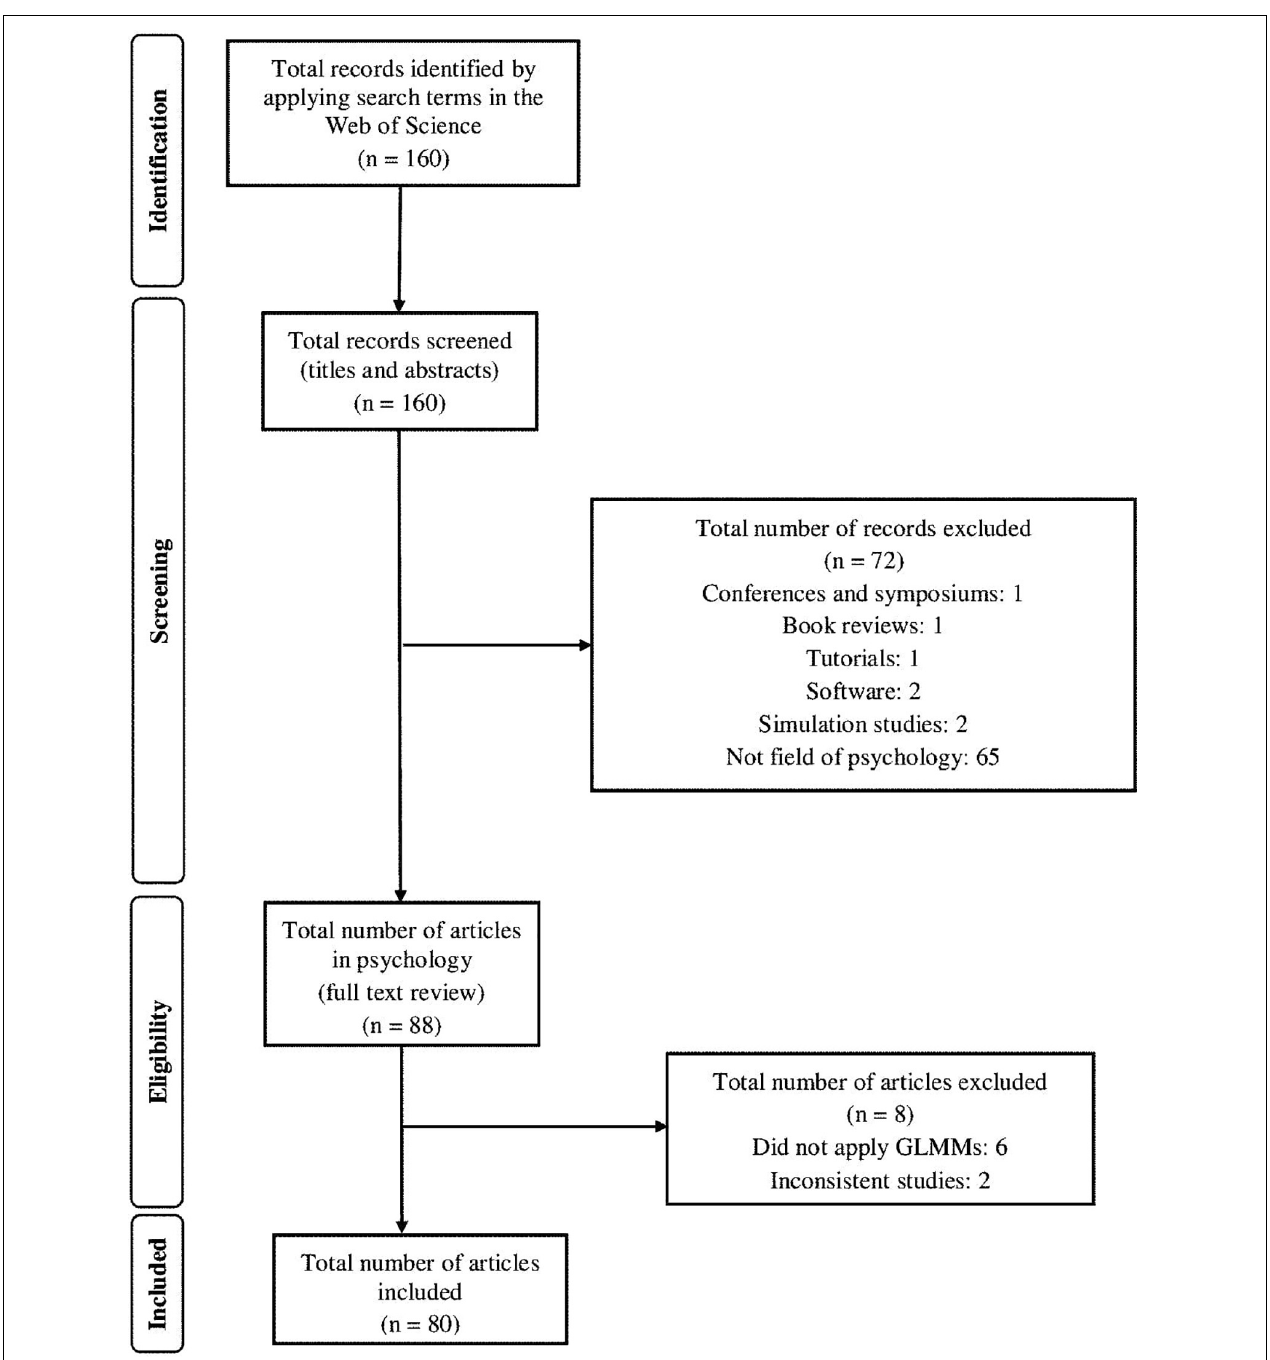
FIGURE 1 | Flowchart showing the selection of articles published in 2018 and included in the systematic